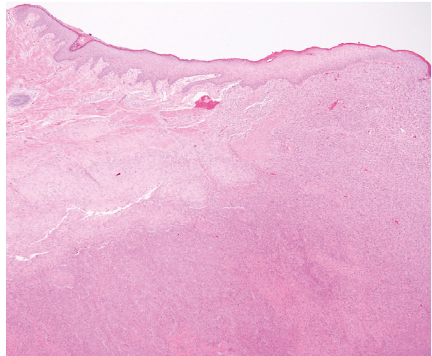
Figure 3: Histopathology with hematoxylin and eosin staining. Scanning view (1x magnification) shows a dermal proliferation of spindled cells with lighter and darker areas.